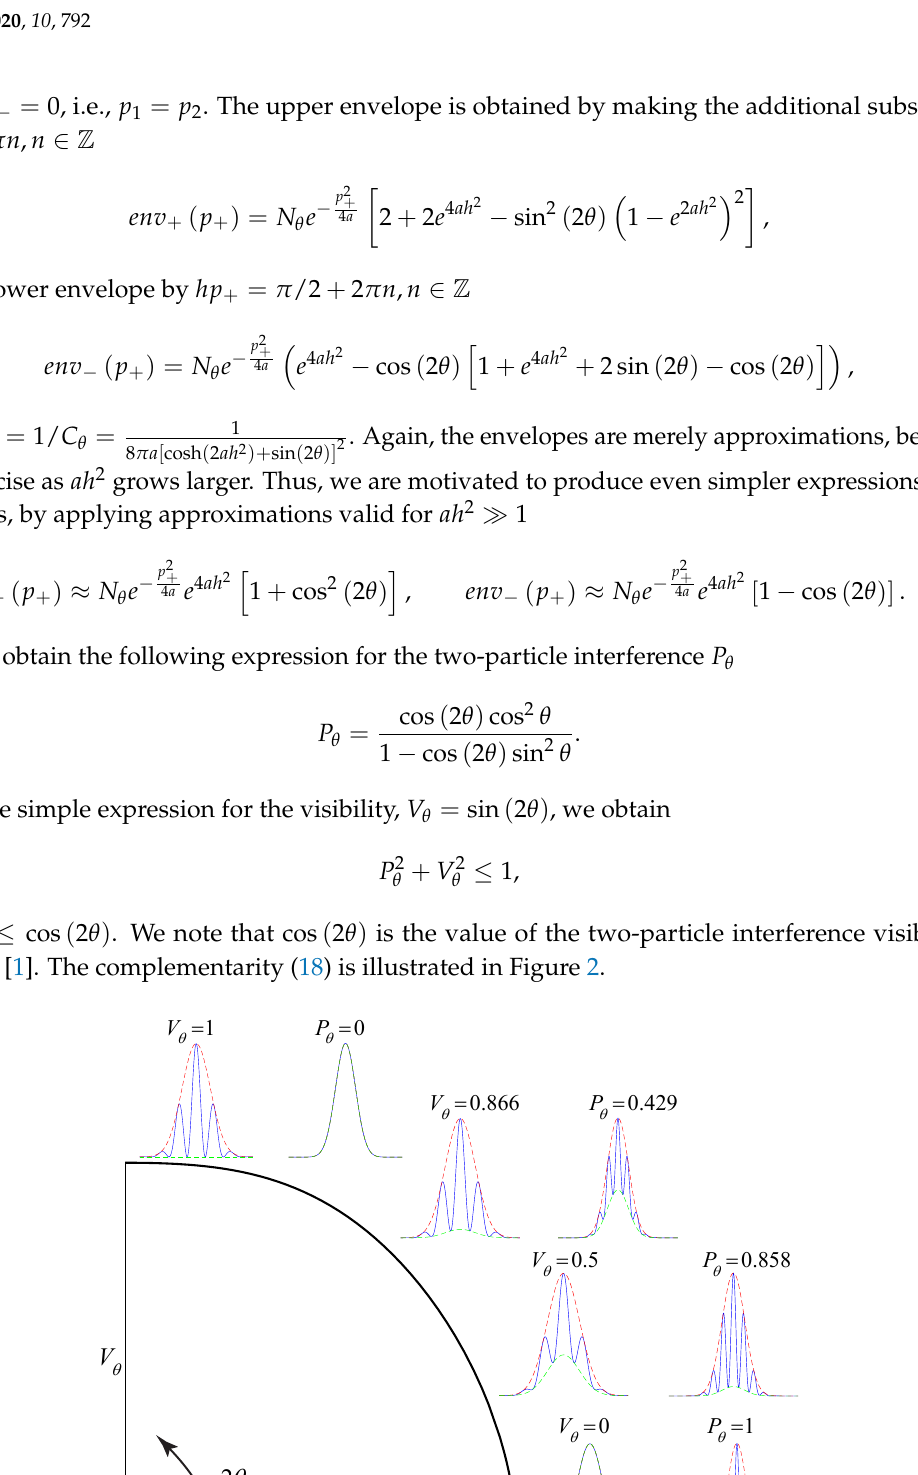
( p ) (7) and ˜ F ( p + , p − = 0 ) (13) for 1 θ 1 , θ + V 2 θ θ